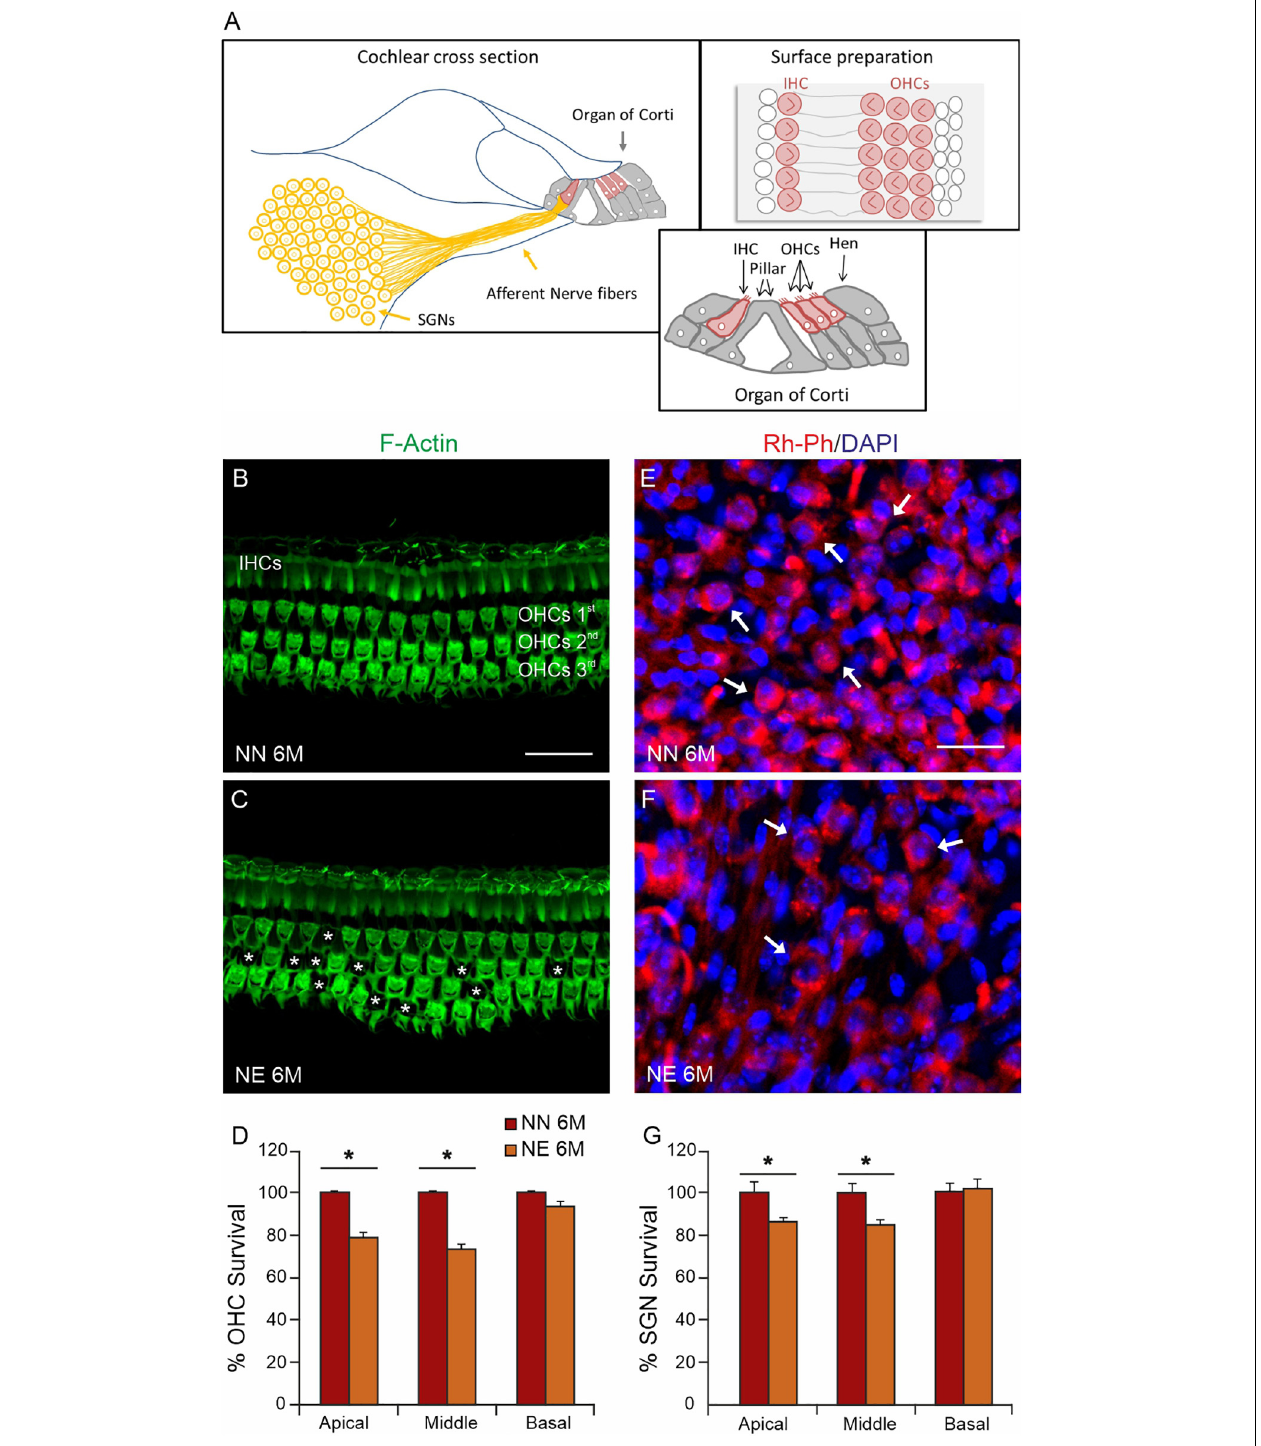
FIGURE 3 | Sensory and neuronal damage in noise-exposed animals. (A) Schematic representation of principal cochlear structures (spiral ganglion neurons-SGNs; neural afferent fibers and organ of Corti) in cochlear section with high magnification of different cell types in the organ of Corti and a schematic representation of cell view in surface preparations of the organ of Corti. IHC: inner ear cell; OHCs, outer hair cells; Hen, Hensen cells. (B,C) Representative images of surface preparations of the organ of Corti (middle turn region) showing hair cells and F-Actin distribution in the middle cochlear turn of no noise-exposed [NN group; (B) ] and noise-exposed [NE group; (C) ] animals of early presbycusis mice of 6 months of age (M). Cochlear organization with well aligned three rows of outer hair cells